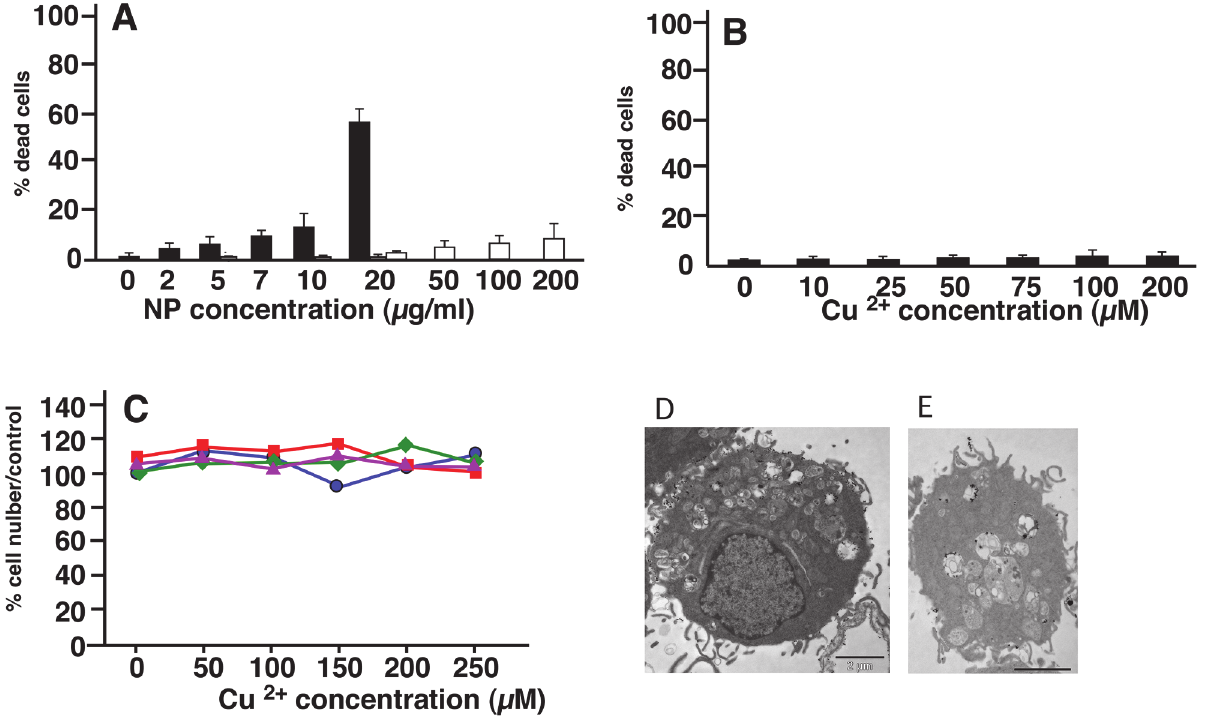
Fig 1. Determination of the cell viability after treatment with copper oxide nanoparticles (A), and copper acetate (B). Experiments were carried out in quadruplicate on independent cultures. Insignificant toxicity was induced by titanium dioxide up to 100 μ g/ml and by copper oxide microparticles up to 50 μ g/ ml. Grey bars show the absence of toxicity of PVP at the concentrations present in the copper oxide dispersions (respectively1, 2 and 4 μ g/ml). In C, surviving cell numbers after a combined treatment by copper acetate alone (blue curve, circles), copper acetate + 25 μ g/ml titanium dioxide (red curve, squares), copper acetate + 10 μ g/ml 250nm latex beads (green curve, diamonds), copper acetate + 25 μ g/ml 1 μ m latex beads (purple curve, triangles). None of the observed variation was significant (Mann Whitney U test). In D and E, Transmission electron microscopy of J774 cells exposed to 50 μ g/ml titanium dioxide nanoparticles for 18 hours (D) or to 10 μ g/ml copper oxide (E).